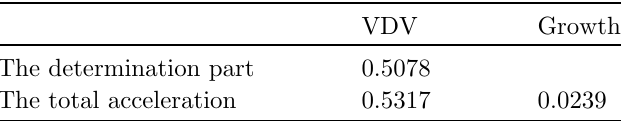
Table 5. The VDV value of the determination part and total